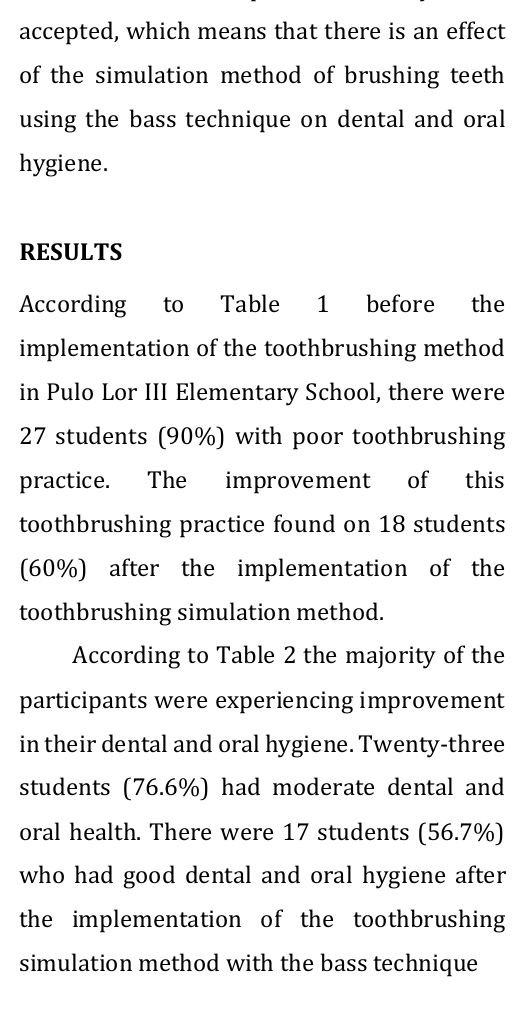
The Practice of Toothbrushing Before and After the Implementation of Toothbrushing Method with Bass Technique